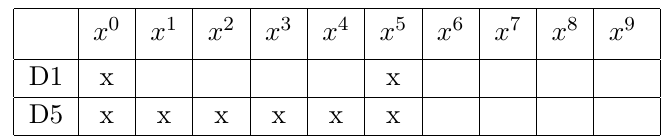
Table 1 . The set-up for Q D 1 D1-branes wrapped on x 5 and Q D 5 D5-branes wrapped on x 5 and CY 2 . This system preserves (4,4) supersymmetry. The field theory lives in the x 0 and x 5 directions and x 1 , x 2 , x 3 , x 4 parameterise the CY 2 . The SO(4) R-symmetry is geometrically realised in the x 6 , x 7 , x 8 , x 9